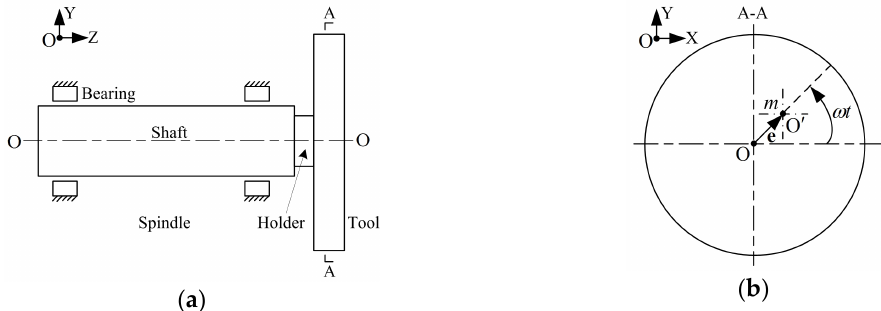
Figure 1. Schematic diagram of a combined rotor and its mass unbalance for a motorized spindle: ( a ) combined rotor of shaft, holder, and tool; ( b ) mass unbalance of tool.